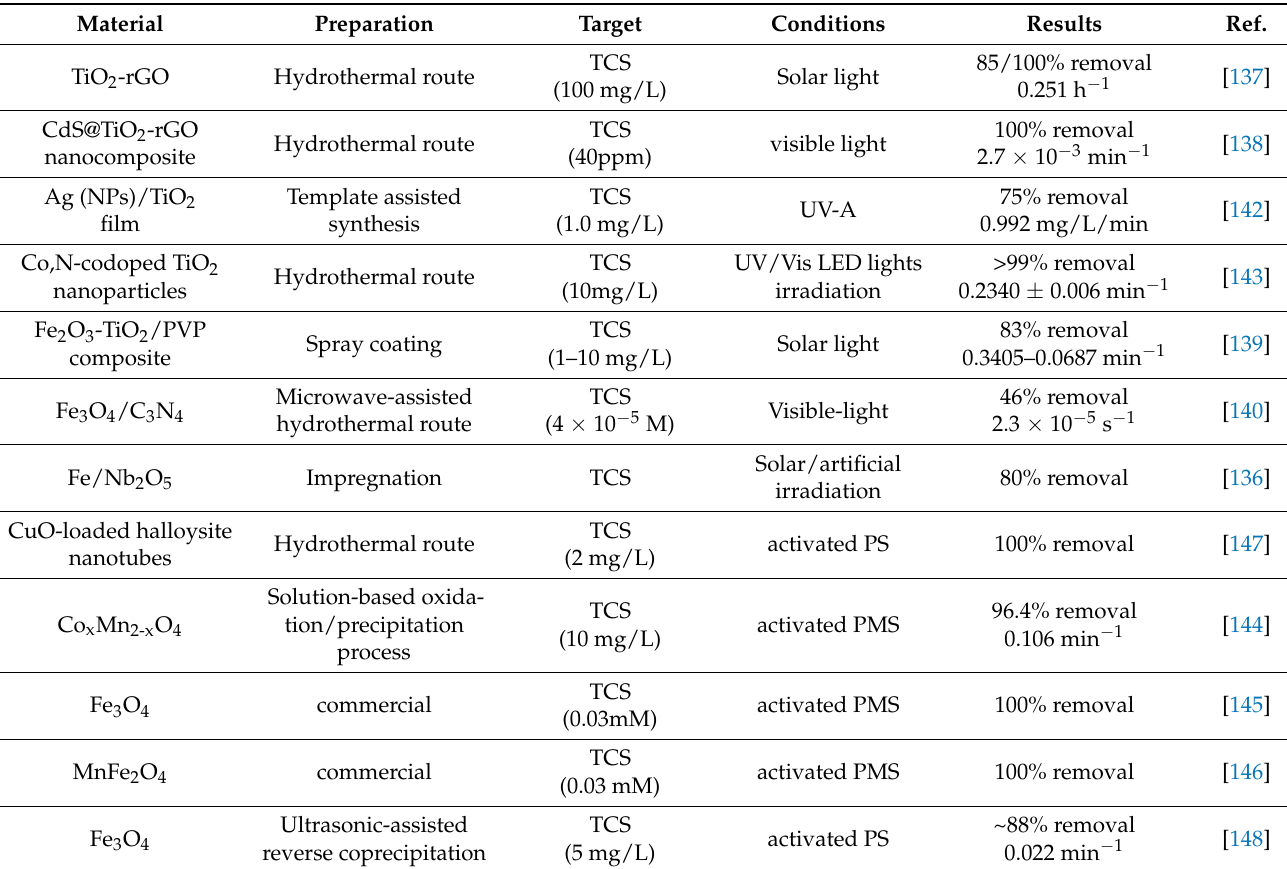
Table 4. Summary of representative metal-oxide-based nanomaterials used for the degradation processes of